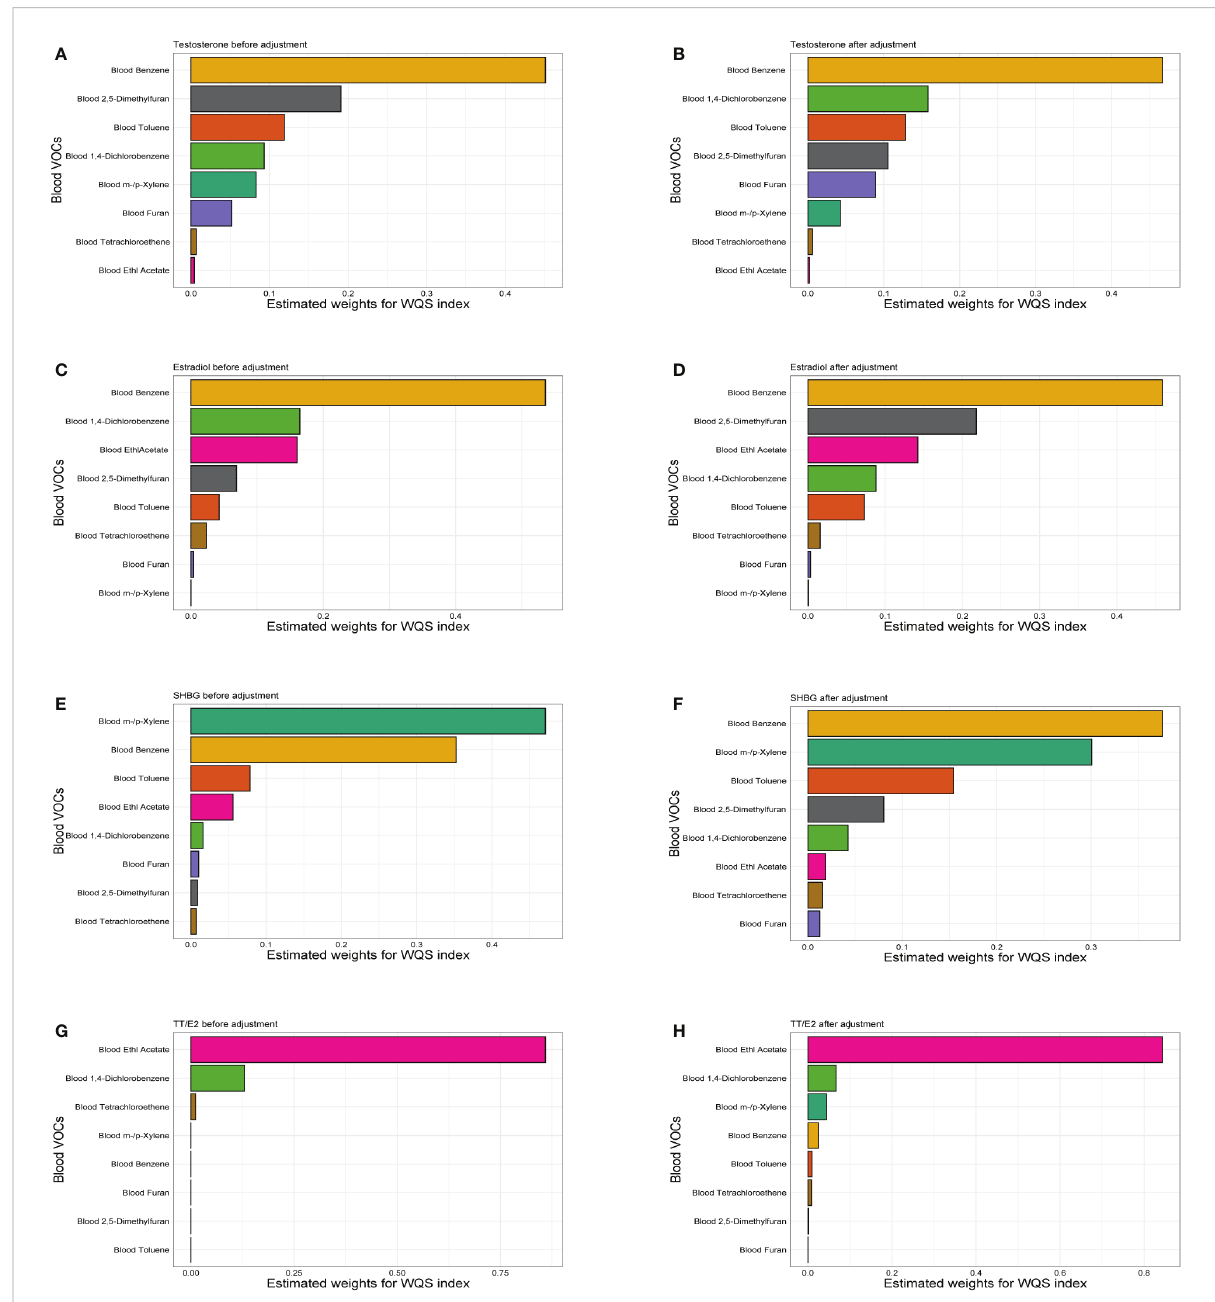
FIGURE 4 The WQS regression model estimated weights of each speci fi c blood VOCs associated with sex hormones. (A) Weights in the WQS index containing speci fi c blood VOCs in the models of male testosterone before adjustment. (B) Weights in the WQS index containing speci fi c blood VOCs in the models of male testosterone adjust for age, race, education, marital status, body mass index, race, family income to poverty ratio, smoking and drinking. (C) WQS model of VOCs and male estradiol before adjustment. (D) WQS model of VOCs and male estradiol after adjustment. (E) WQS model of VOCs and male SHBG before adjustment. (F) WQS model of VOCs and male SHBG after adjustment. (G) WQS model of VOCs and male TT/E2 before adjustment. (H) WQS model of VOCs and male TT/E2 before